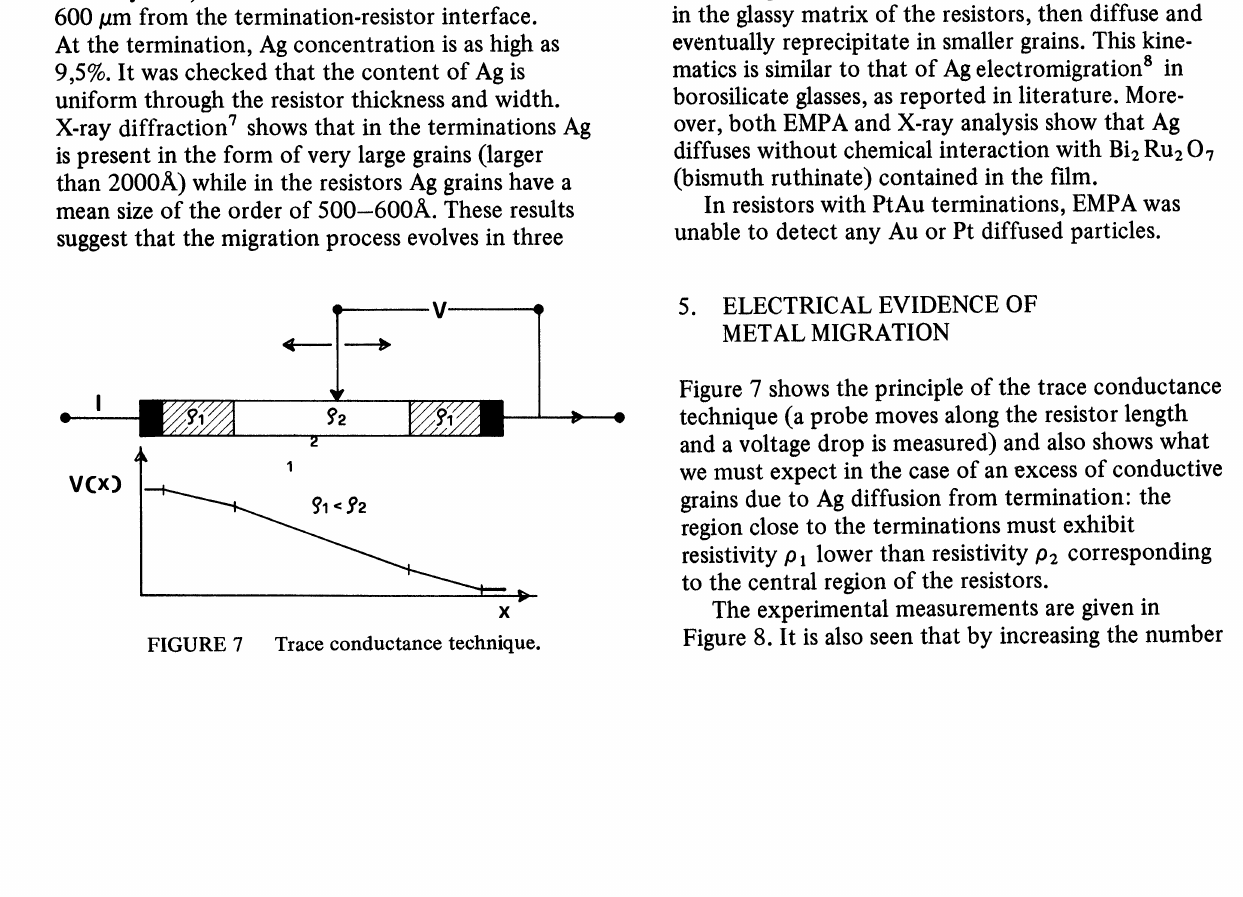
FIGURE 7 Trace conductance